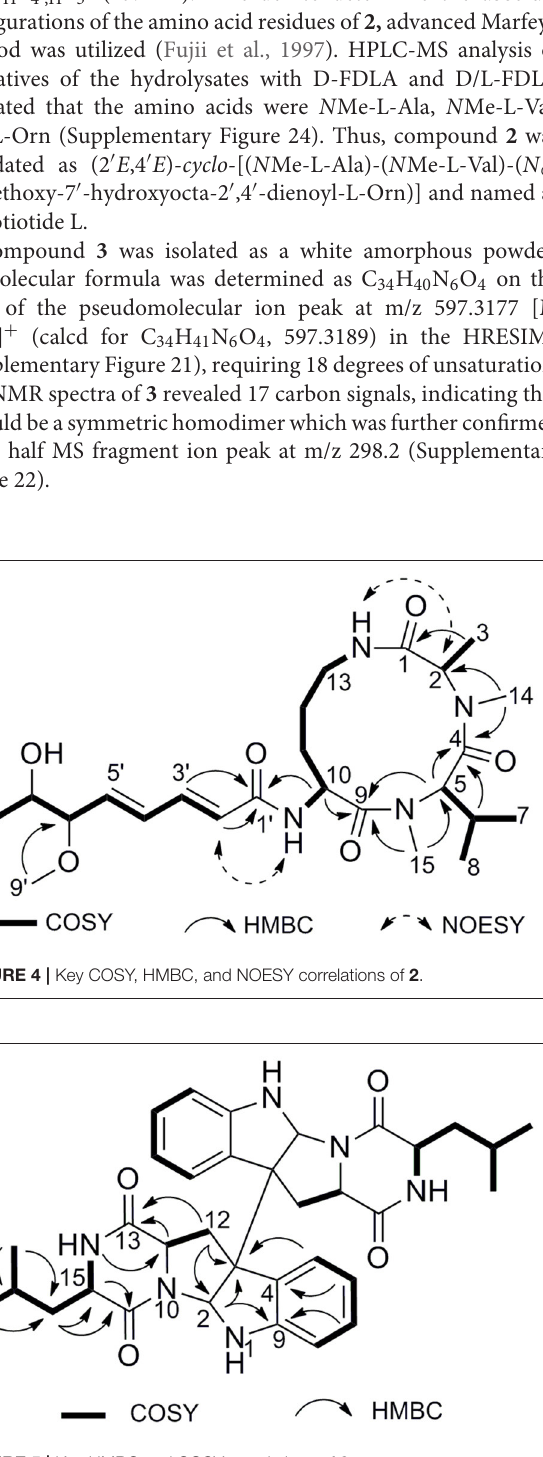
FIGURE 5 | Key HMBC and COSY correlations of 3 .